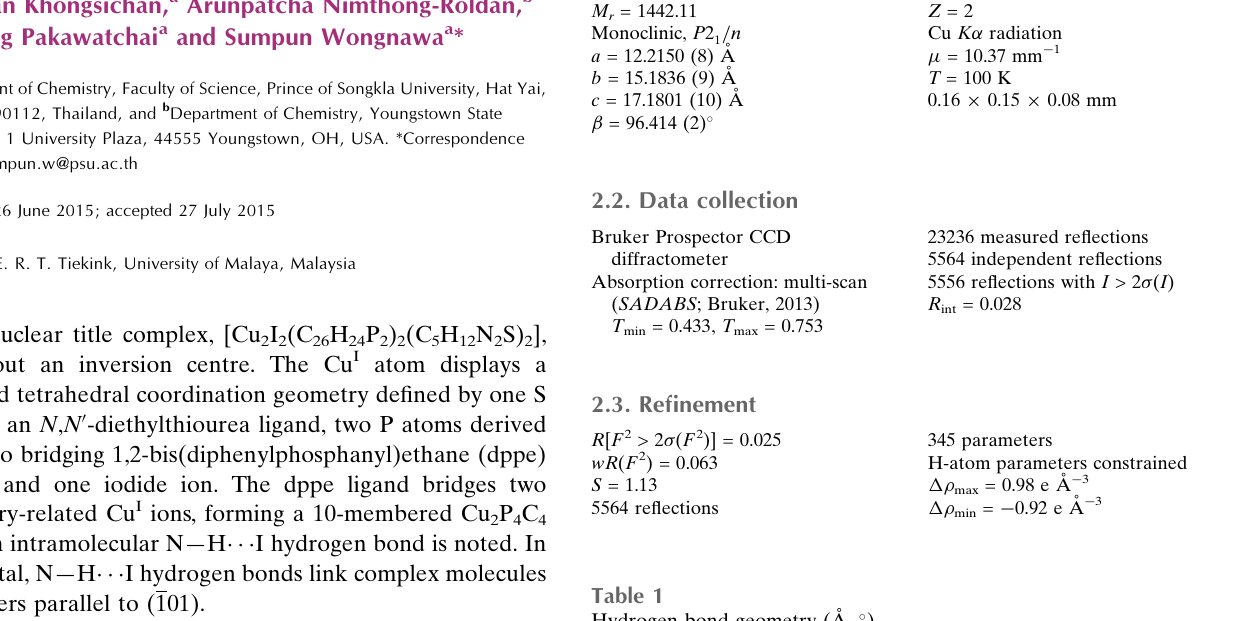
Hydrogen-bond geometry (A˚ , (cid:3)